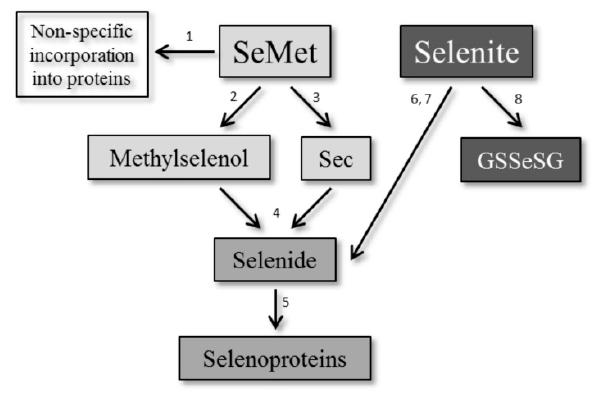
Figure 1. Metabolism of selenomethionine (SeMet) and selenite. (1) SeMet can be incorporated non-specifically into proteins instead of methionine [22]. Otherwise, it is transformed enzymatically either by (2) γ-lyase into methylselenol [23] or through (3) transselenation into selenocysteine (Sec) [24]. (4) Both are further degraded to selenide, which is used to (5) newly synthetize Sec directly at the tRNA Ser/Sec . Selenite is either metabolized by the (6) glutaredoxin [25] or by the (7) thioredoxin [26] system yielding selenide. (8) Alternatively, selenite may react with intracellular glutathione (GSH) to form selenodiglutathione (GSSeSG)